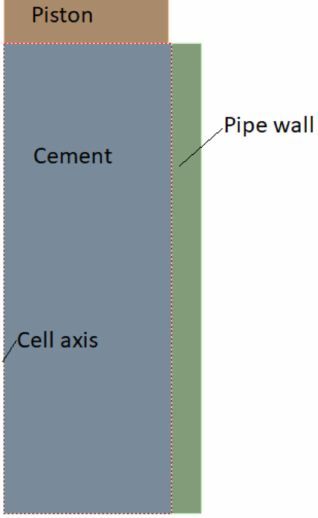
Figure 4. Model used for the study.